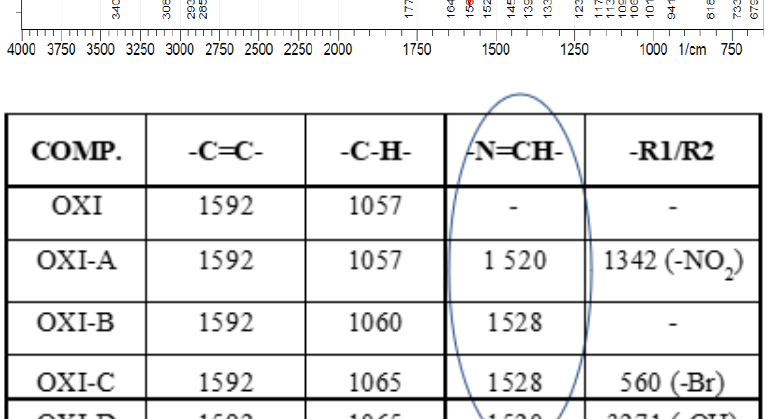
Figure 3. IR spectra of oxytetracycline derivatives and the peaks corresponding to functional groups.